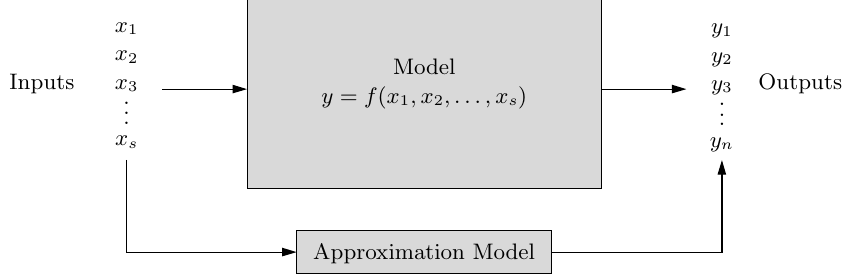
Figure 2: Computer model and experiments for an industrial